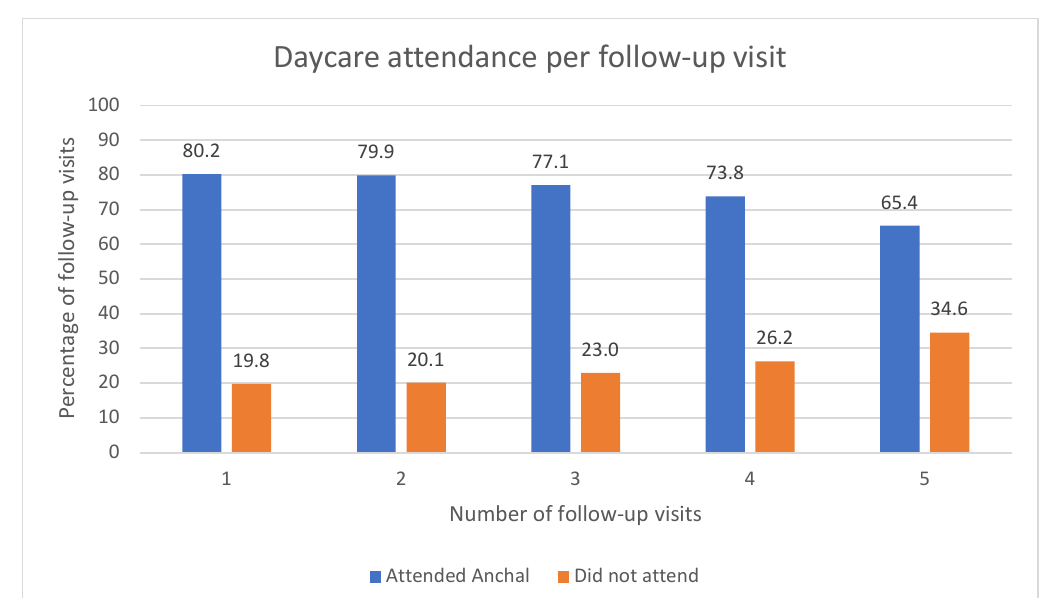
Figure 1. Percentages of daycare attendance per follow-up visit.